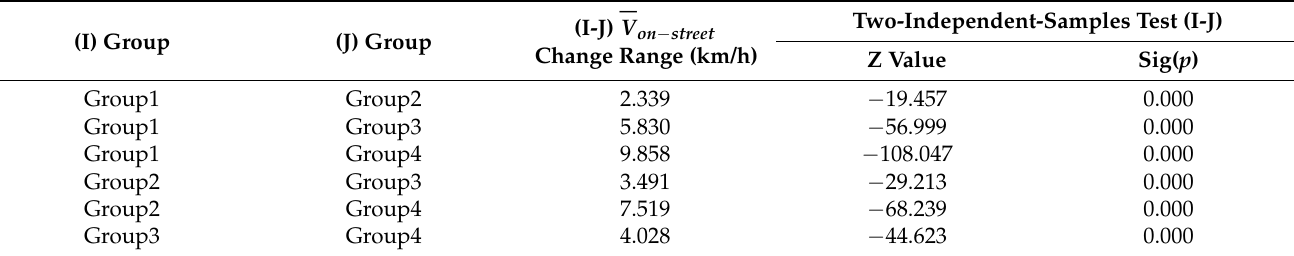
Table 6. Two-independent-samples test (I-J) of the V on − street of road traffic flow.